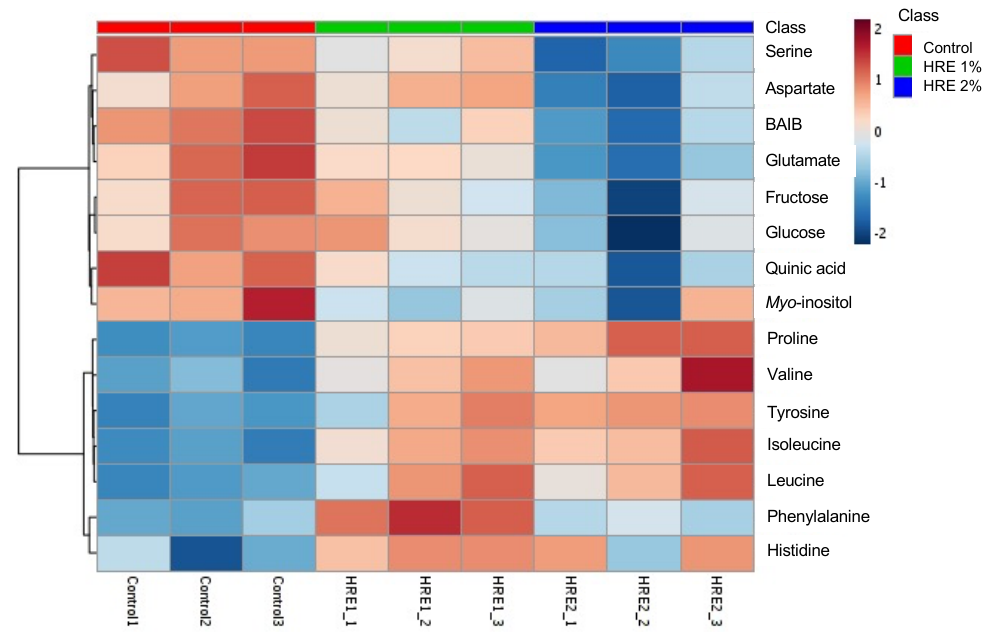
Figure 6. Heatmap of significantly changed lettuce metabolites after 3 days of water, 1%, or 2% horseradish aqueous extract (HRE) treatments. BAIB = beta-aminoisobutyric acid.